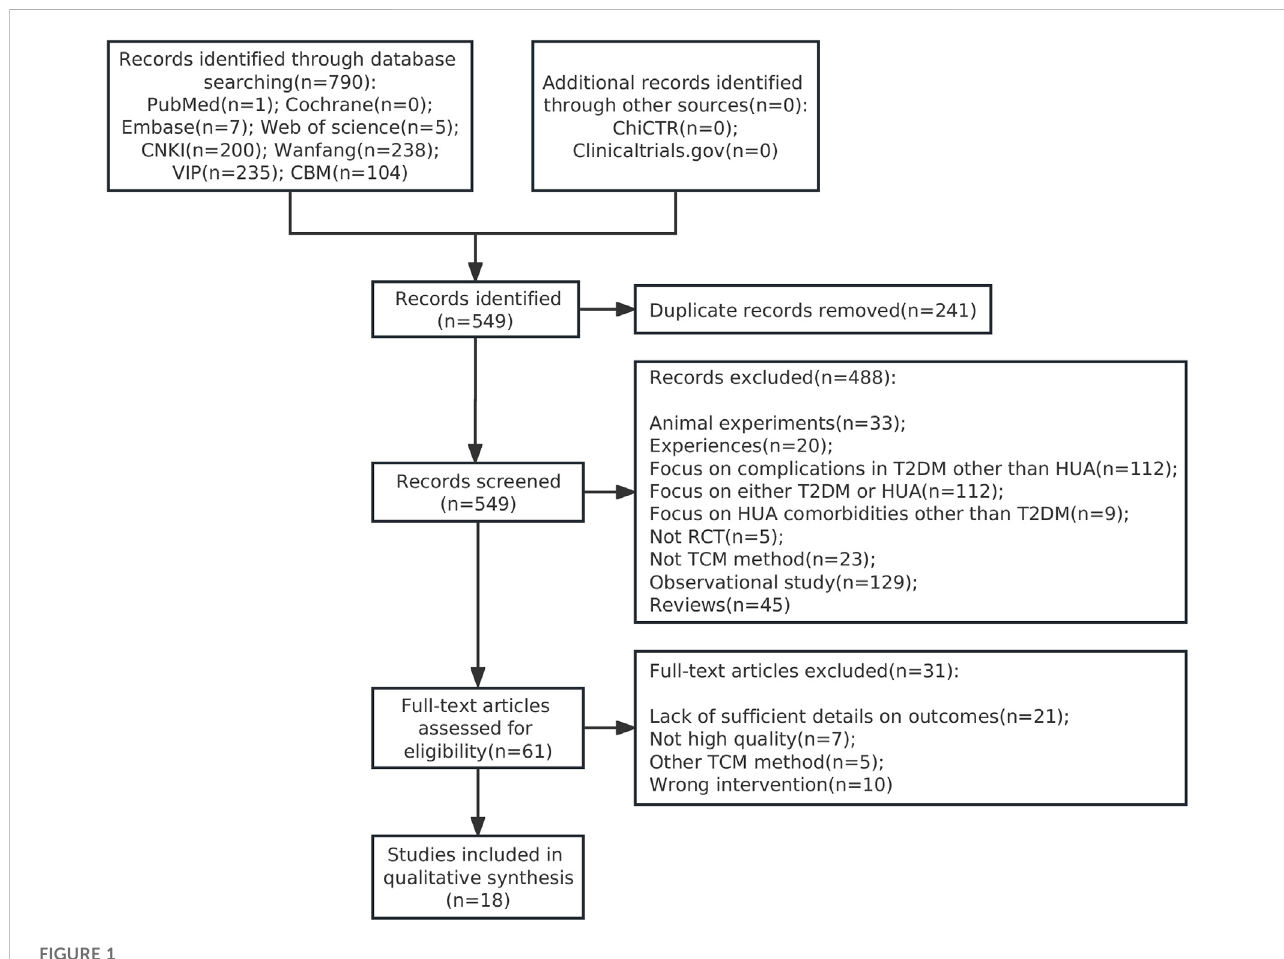
FIGURE 1 Flow diagram of studies selection